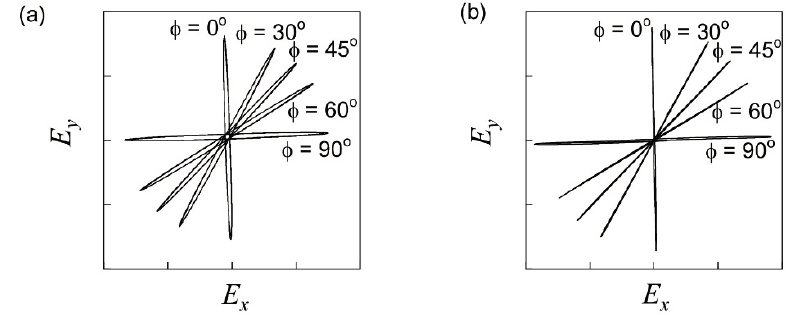
Figure 8. Calculated transmitted light propagating through the 1D PC with the NLC defect at a wavelength of 595 nm as a function of ϕ . The numbers of periods of 1D PC are ( a ) 10 and ( b )